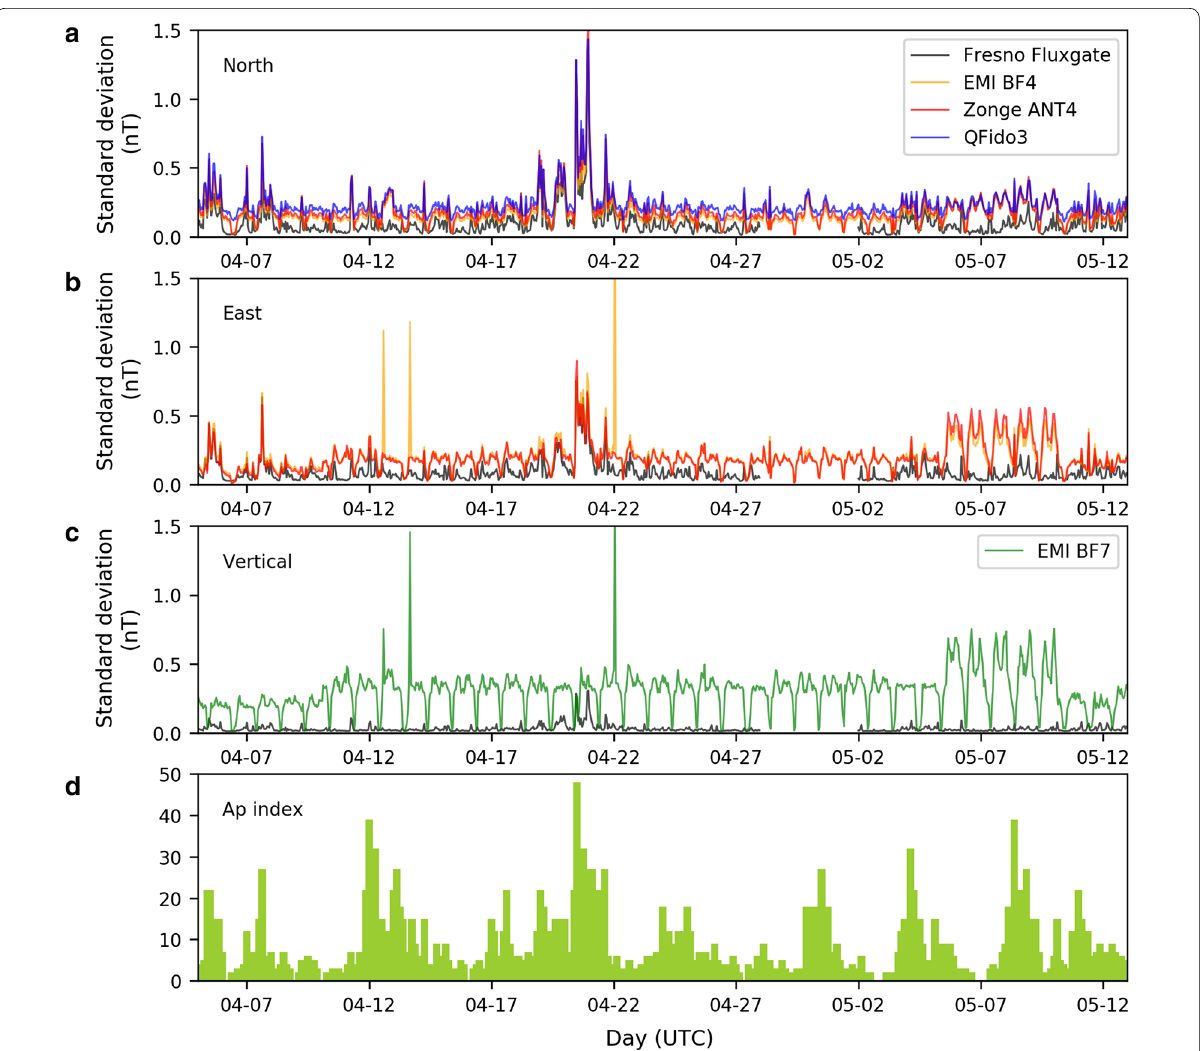
Fig. 14 Standard deviations of amplitudes for each hour of data calculated individually for each sensor: a north-oriented magnetometers; b east- oriented sensors; and c vertical sensors, at Jasper Ridge and Fresno, for April 5, 2014 to May 12, 2014. Fresno data are not available for April 29, 2014 to May 1, 2014. d Geomagnetic activity index Ap for the same time